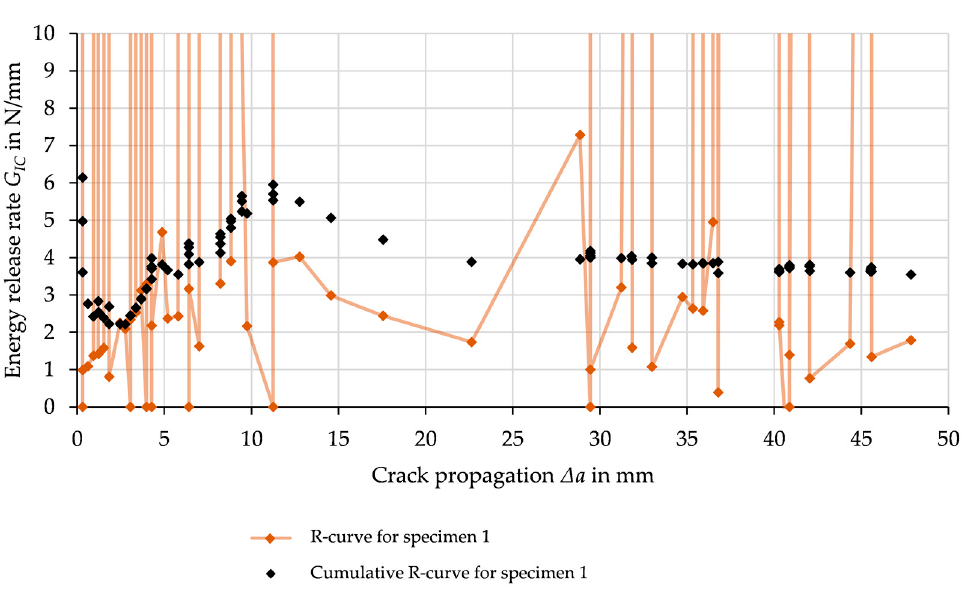
Figure 8. Comparison of experimental determined R-curve and cumulative R-curve for specimen 1.